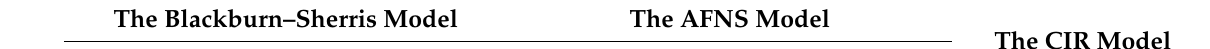
Table 4. RMSE by Comparing the Actual and Best-Estimate Survival Probabilities of the 1916 Cohort. The Blackburn–Sherris Model